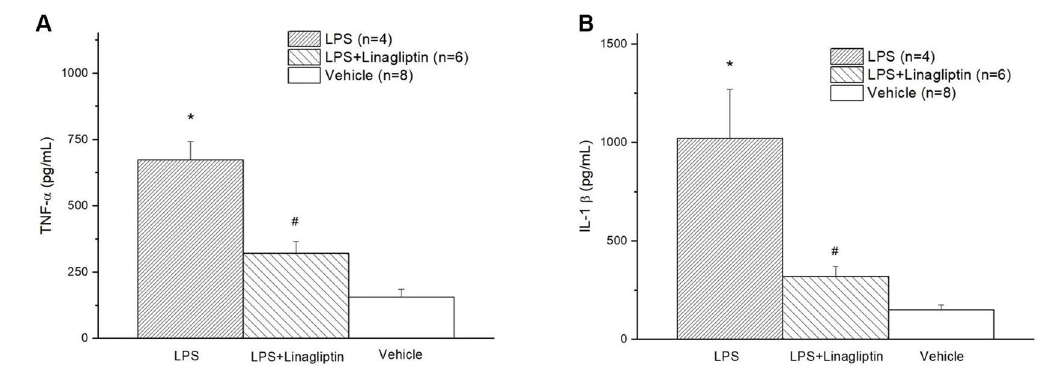
Figure 6. Changes in serum ( A ) tumor necrosis factor- α (TNF- α ) and ( B ) interleukin-1 β (IL-1 β ) after endotoxic shock in conscious rats. * p < 0.05 for the LPS group compared with the Vehicle group. # p < 0.05 for the LPS + Linagliptin group compared with the LPS group. Vehicle ( n = 8), LPS ( n = 4), and LPS + Linagliptin ( n = 6) groups at 48 h after LPS